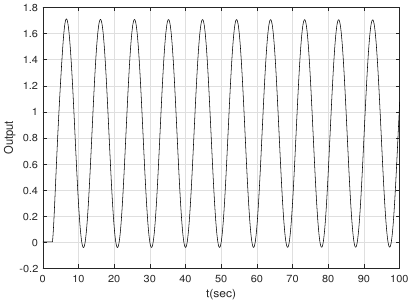
Figure 11. Unit step response of Example 3 for the second order approximation and the critical point h = 2 .